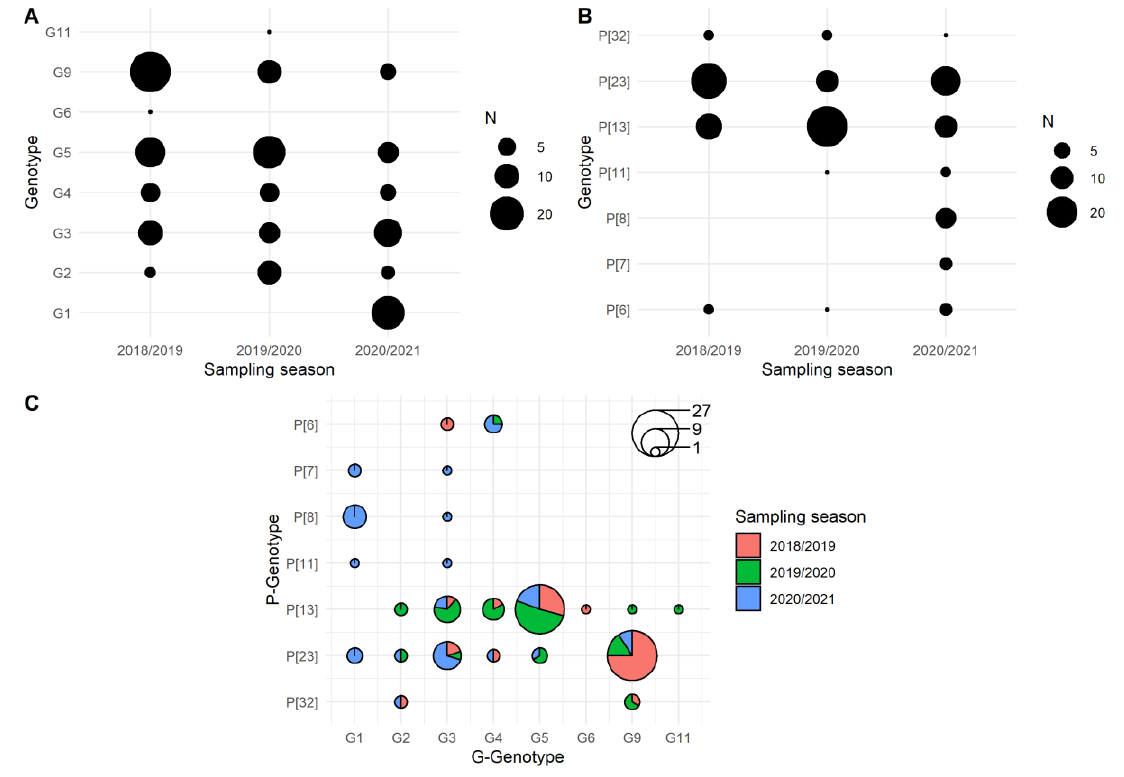
Figure 2. Temporal distribution of RVA’s G genotypes ( A ), P genotypes ( B ) and G/P genotype combinations ( C ) detected in domestic pigs. The circle sizes are proportional to the number of detected RVA